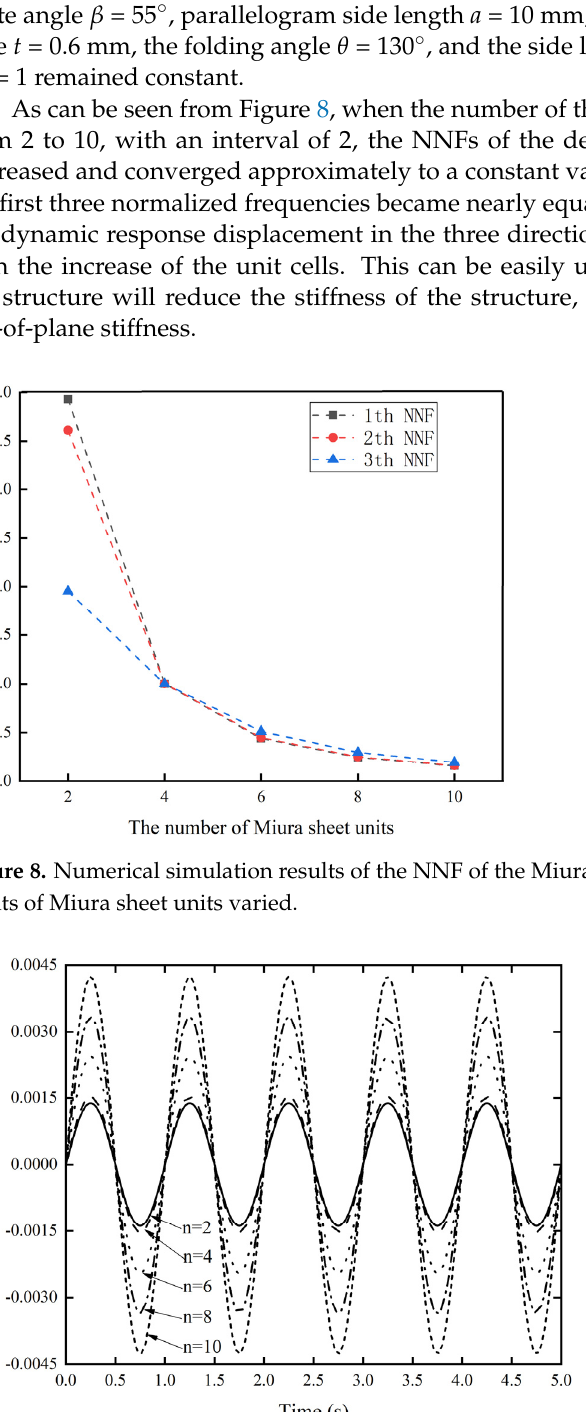
Figure 7. DDR of the Miura tube for different side length ratios of parallelogram a / b ( θ = 130 ° , t = 0.6mm) ( a ) x -displacement of the Miura tube under force along the x -direction, ( b ) y -displacement